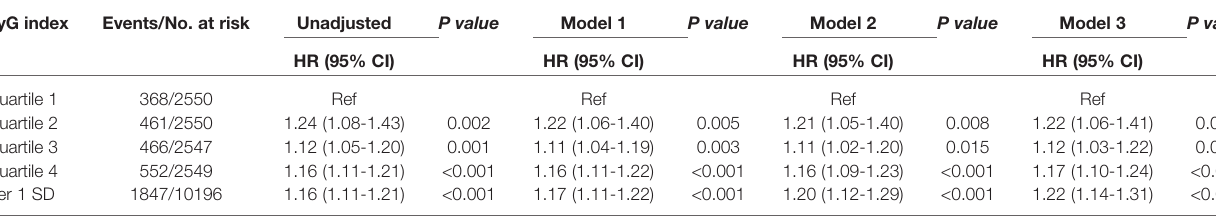
Model 1: Adjusted for baseline age, sex, previous cardiovascular event, race, BMI, education, systolic blood pressure, and diastolic blood pressure. Model 2: Adjusted for model 1 covariates plus baseline eGFR, HbA1c, total plasma cholesterol, plasma LDL-C, live alone, duration of diabetes and depression. Model 3: Adjusted for model 2 covariates plus treatment with statins, biguanide, aspirin, ACEI/ARB, and insulin. BMI, body mass index; LDL-C, low-density lipoprotein cholesterol; ACEI, angiotensin-converting enzyme inhibitor; ARB, angiotensin receptor blocker; CI, con fi dence interval; HR, hazard ratio; CV, cardiovascular; MACEs, major adverse cardiovascular events; MI, myocardial infarction; TyG, triglyceride-glucose; HbA1c, hemoglobin